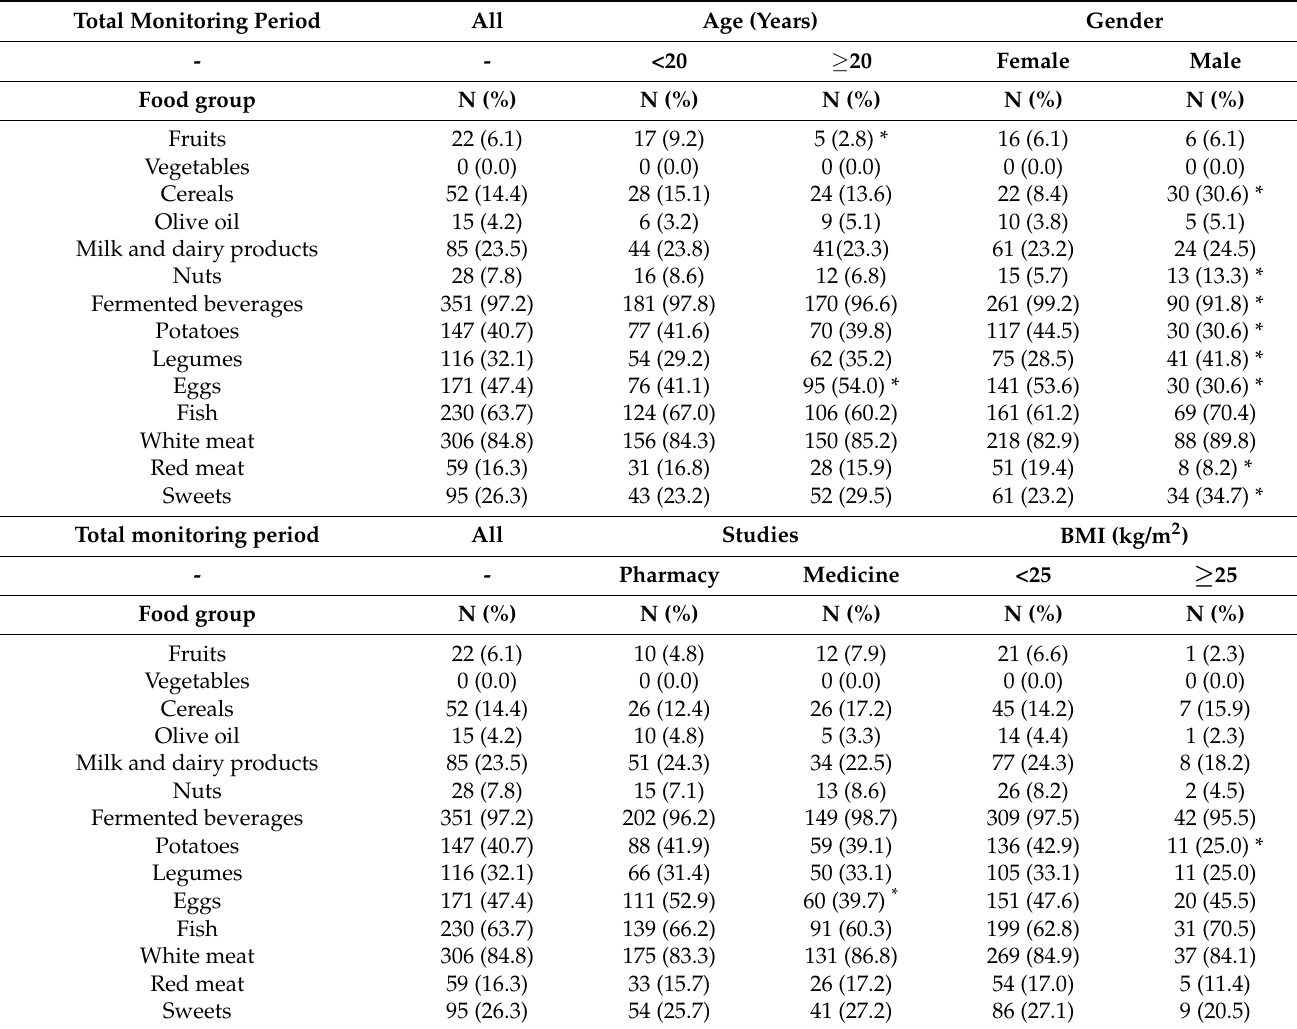
Table 6. Stratification of adherence to MD items (food groups) (total monitoring